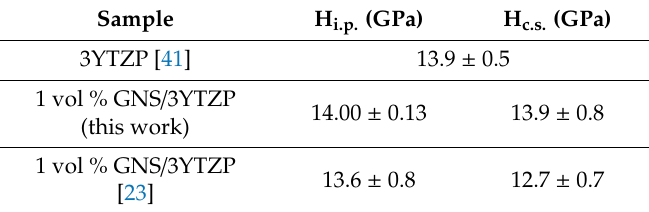
Table 3. Vickers hardness for the composite in this study, compared with a monolithic 3YTZP ceramic and a composite prepared with commercial graphene